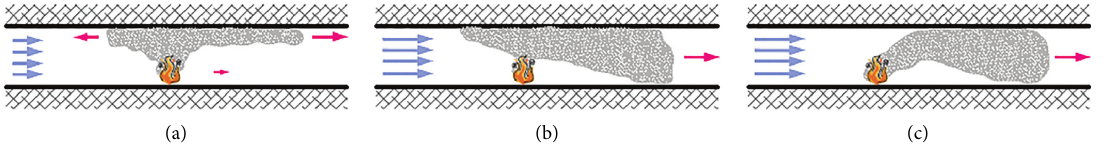
Figure 6: Smoke propagation depending on velocity of air flow [28].